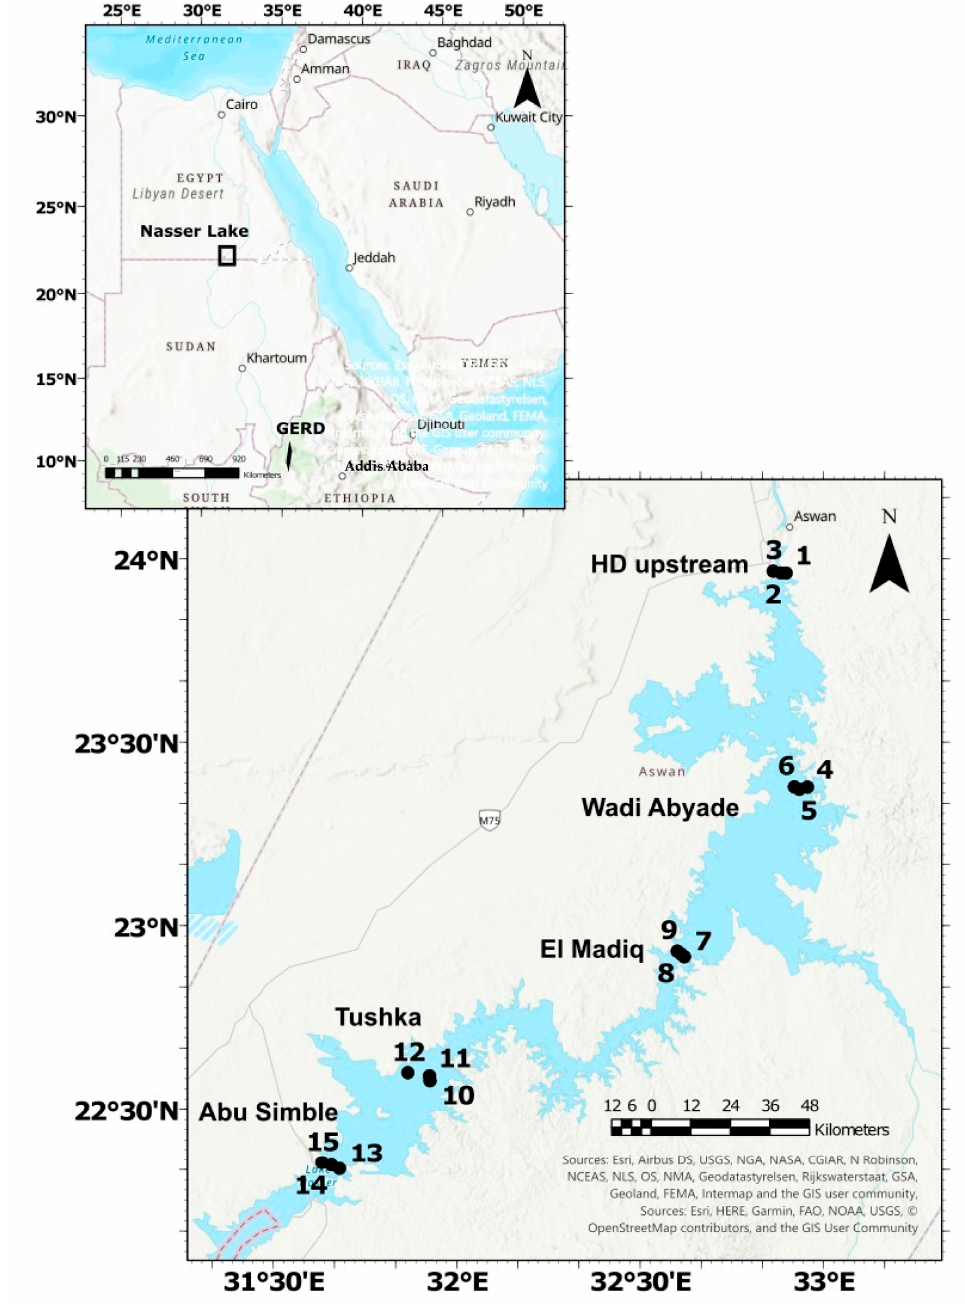
Figure 1. The map of the location and the sampling sites 1–15 in Lake Nasser, GERD—Grand Ethiopian Renaissance Dam.